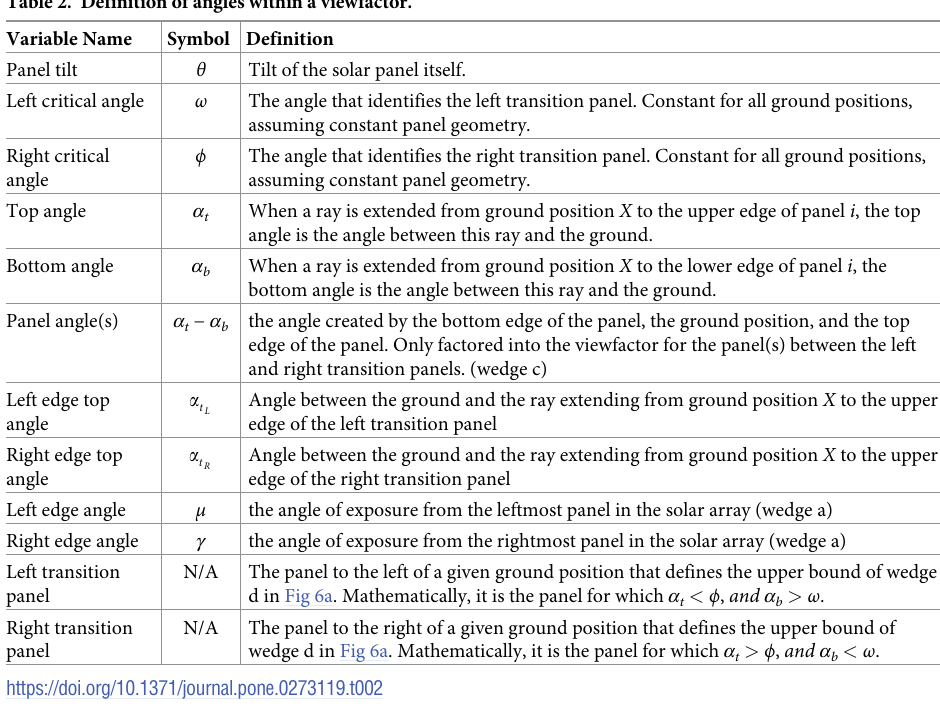
Table 2. Definition of angles within a viewfactor.